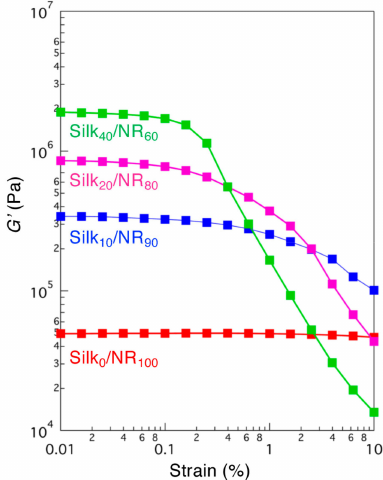
Figure 4. The strain dependence of G’ of silk / NR composites with di ff erent silk contents. The frequency was fixed at 10